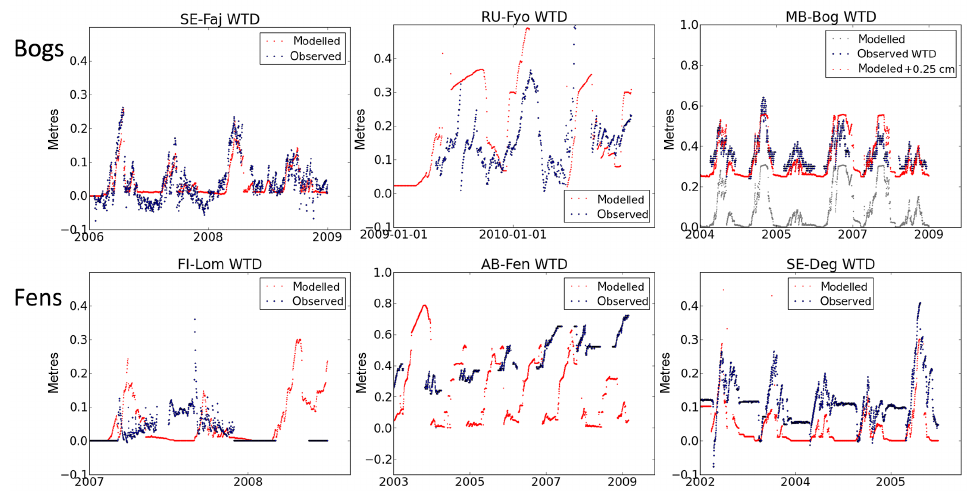
Figure 4. Simulated and observed daily average water table depth (m) in three bogs (MB-Bog, RU-Fyo, SE-Faj) and three fens (AB-Fen, FI-Lom,